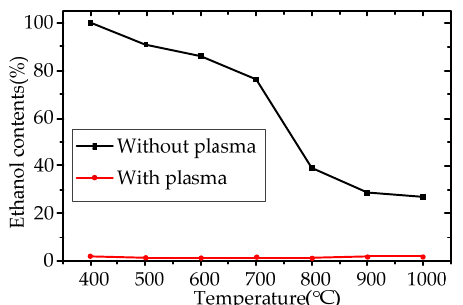
Figure 3. The ethanol contents at different temperatures in the exhaust gas, with and without plasma treatment.